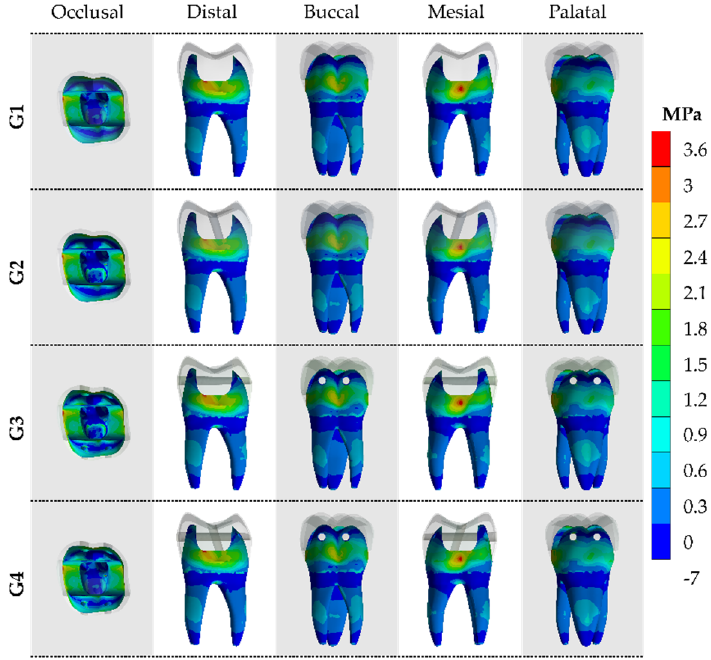
Figure 5. The maximum principal stress (MPa) concentration from five different viewpoints in the dentin tissue according to the GFP treatment.